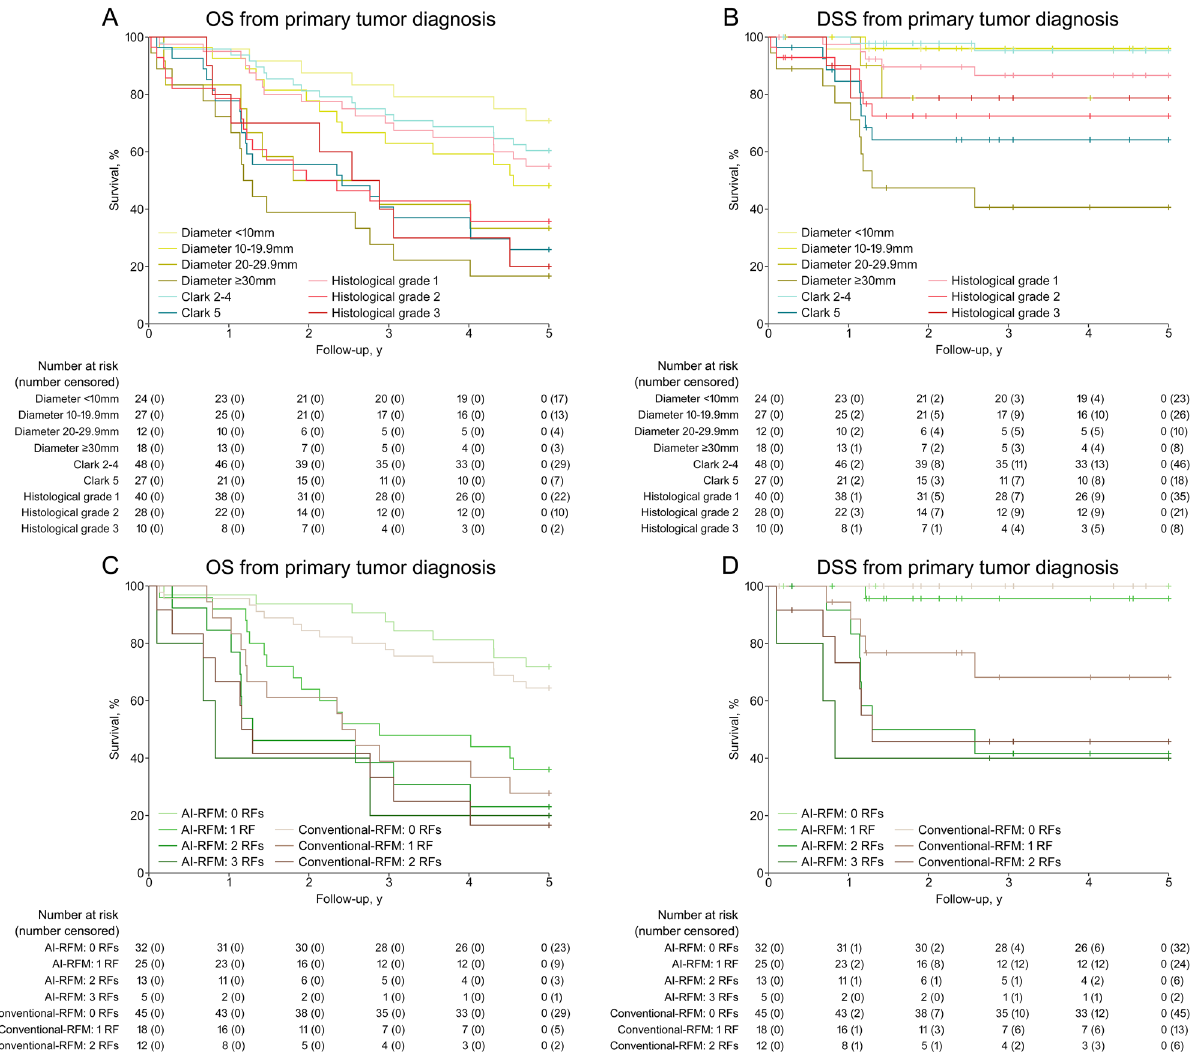
Figure 3. Kaplan–Meier overall survival (OS) and disease-specific survival (DSS) estimates calculated from the initial diagnosis of primary cSCC (rapid metastasis and non-metastatic cohorts, total tumor n = 81). ( A ) OS and ( B ) DSS estimates of cSCCs based on classification by primary tumor diameter, Clark’s level and histologic grade. OS ( C ) and DSS ( D ) estimates of cSCCs based on classification by artificial intelligence -risk factor model (AI-RFM) taking into account prediction by AI as metastatic, tumor diameter ≥ 30 mm and Clark’s level 5 as risk factors, and by conventional-RFM taking into account tumor diameter ≥ 30 mm and Clark’s level 5 as risk